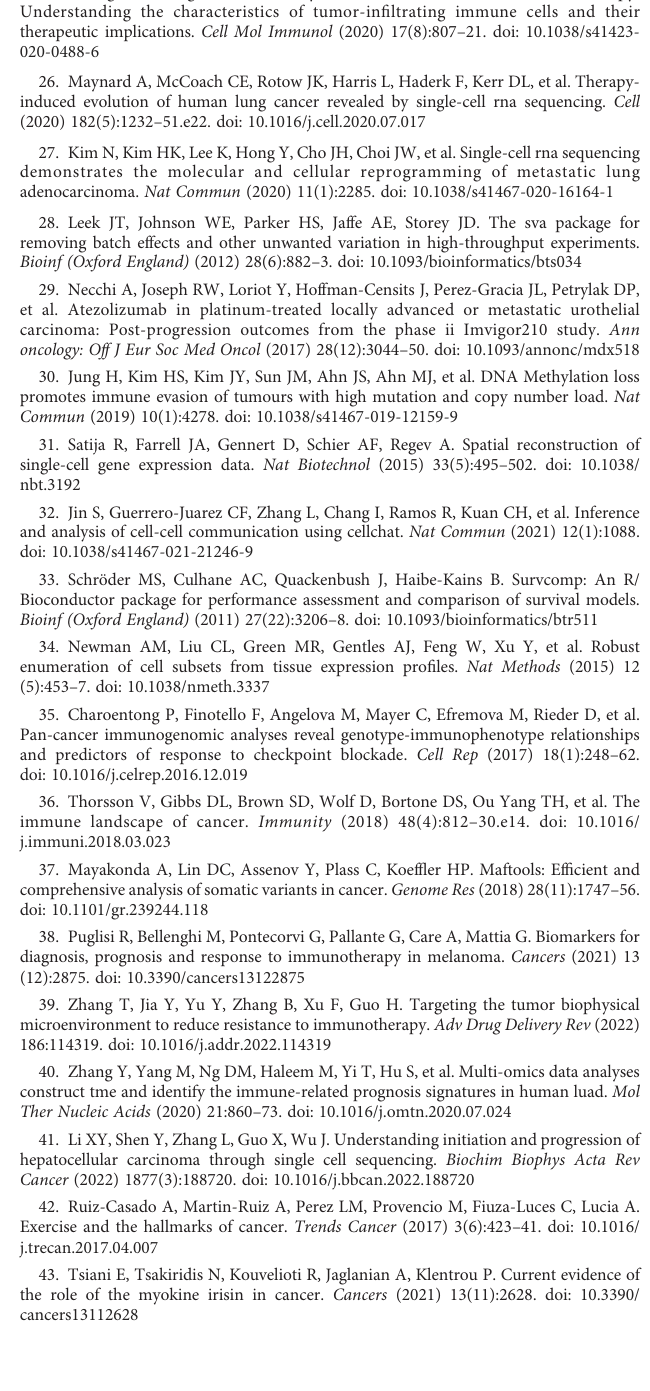
(C) ROC curves in the GEO cohort showing the predictive accuracy of MFI and different immune markers. (D) Prediction of immunotherapy response rates for high and low MFI groups in the GEO cohort via Subclassmapping